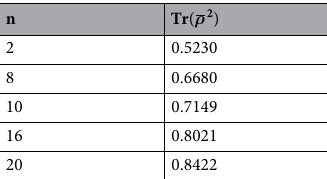
Table 1. The relation between the coherence ratio and the chain length n for the constructed control gate. The spectrum of the noise is constant.